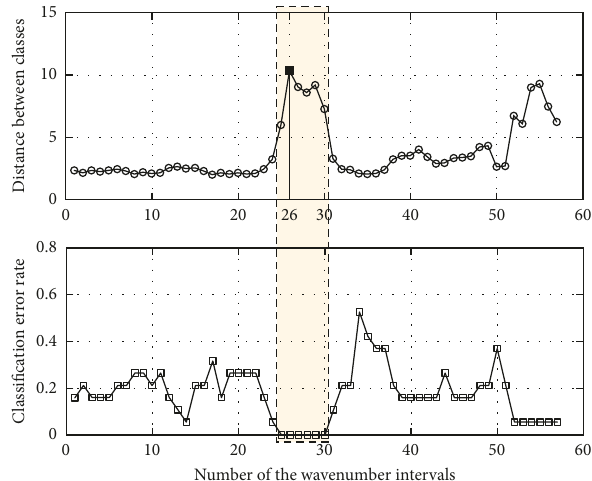
Figure 3: Variation of the classification performance of SIMCA with spectral intervals for Class 1 and 2. SIMCA: soft independent modelling of class